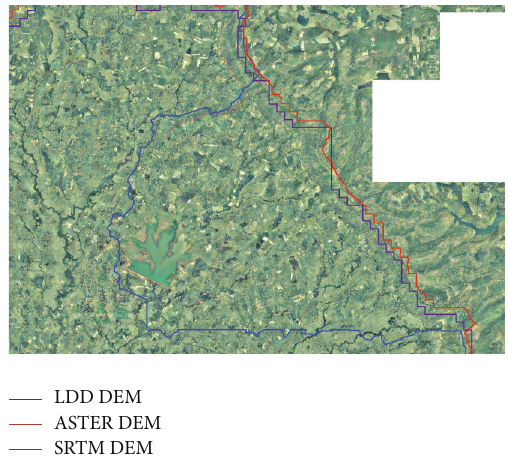
Figure 11: Topographic checking via visual